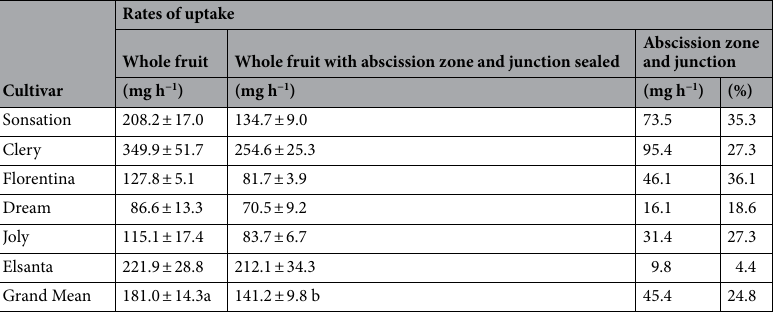
Table 4. Rates of osmotic water uptake into detached strawberries of selected cultivars. Water uptake was quantified on a whole fruit basis and after sealing abscission zones of petals and stamina, and junction calyx- receptacle (‘abscission zone and junction sealed’) using silicone rubber. The contribution of the abscission zone and the junction was calculated by subtracting the uptake in the sealing treatment from that of the non-sealed control. Non-sealed fruit served as control. a Mean separation within main effects by Tukey’s test, P = 0.05. No interaction between main effects was found by ANOVA